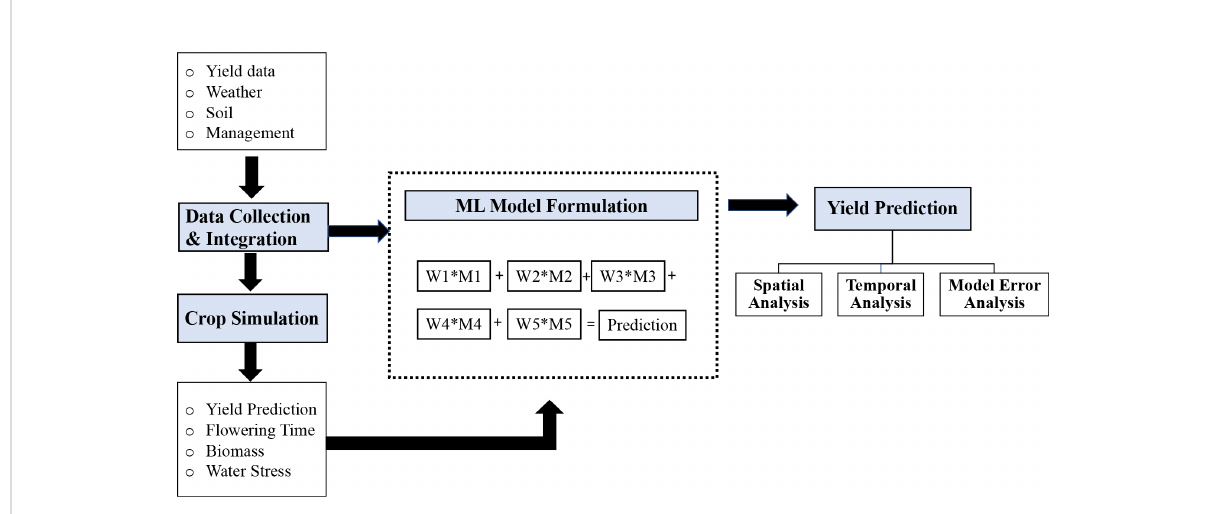
FIGURE 1 Conceptual framework of the proposed method. The fi rst step is data collection and integration. The preprocessed data were used for both crop simulation models and ML models. The fi nal prediction model was an optimized weighted ensemble model, where M1, M2, M3, M4, and M5 were the fi ve prediction models, and W1, W2, W3, W4, and W5 were the weights assigned to each